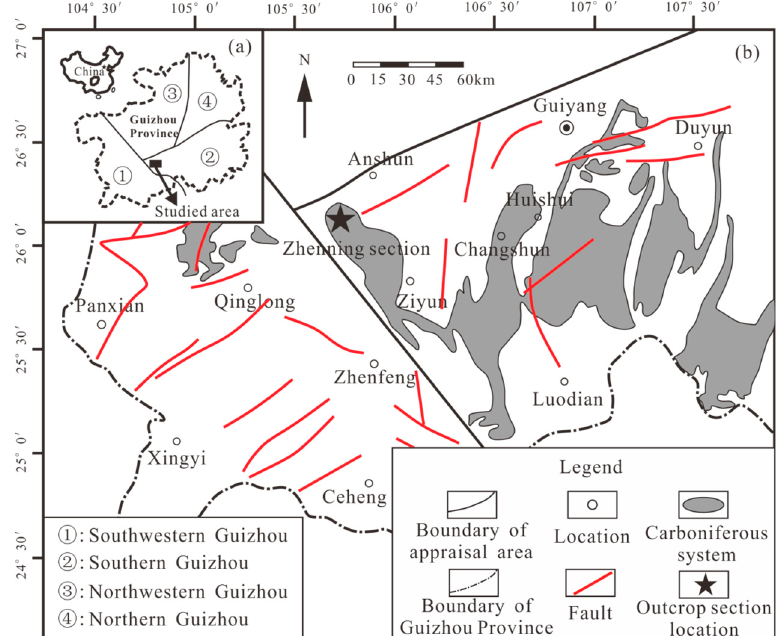
Figure 1. The simplified geologic map of the study area showing the location of sampling outcrop (star), southwest of Anshun city in Southern Guizhou, Southwest China. Base map modified from [27].